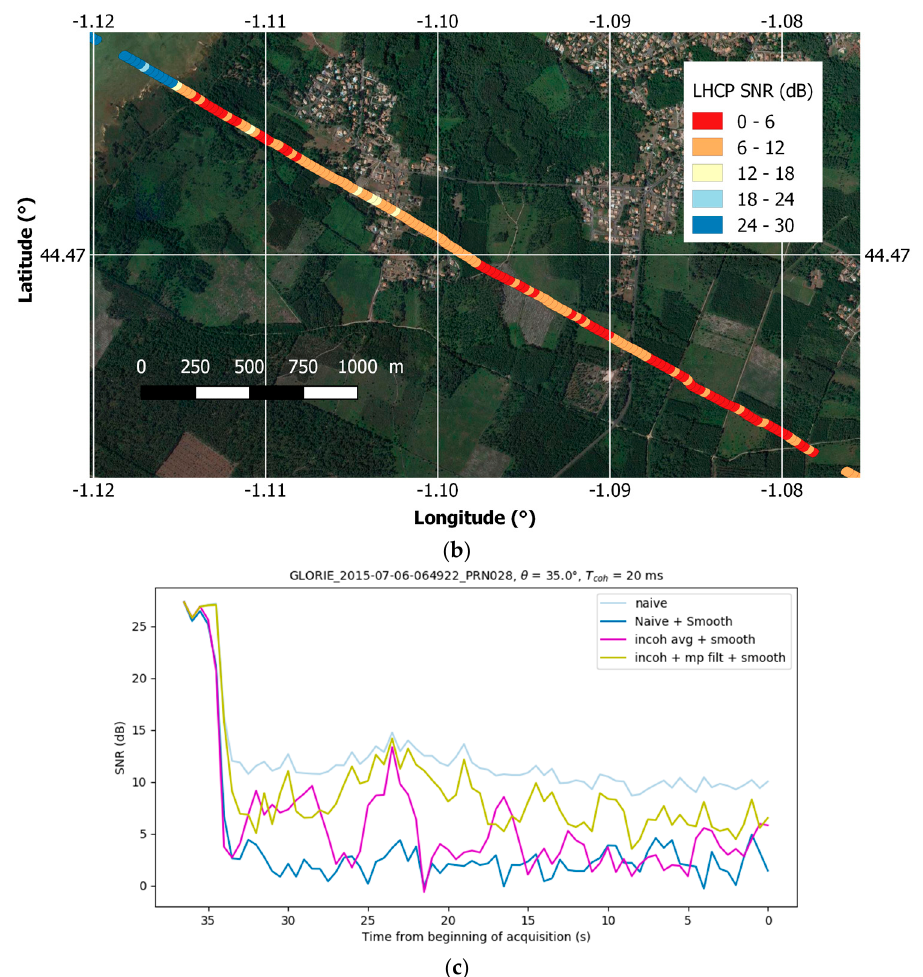
Figure 14. Reflected LHCP SNR for a transect over water and land for PRN28 at 35° elevation. ( a ) using naïve + smooth technique and overlaid with a google Earth Image; ( b ) using the new proposed approach and also overlaid with a google Earth image; ( c ). Comparison between the different methods.